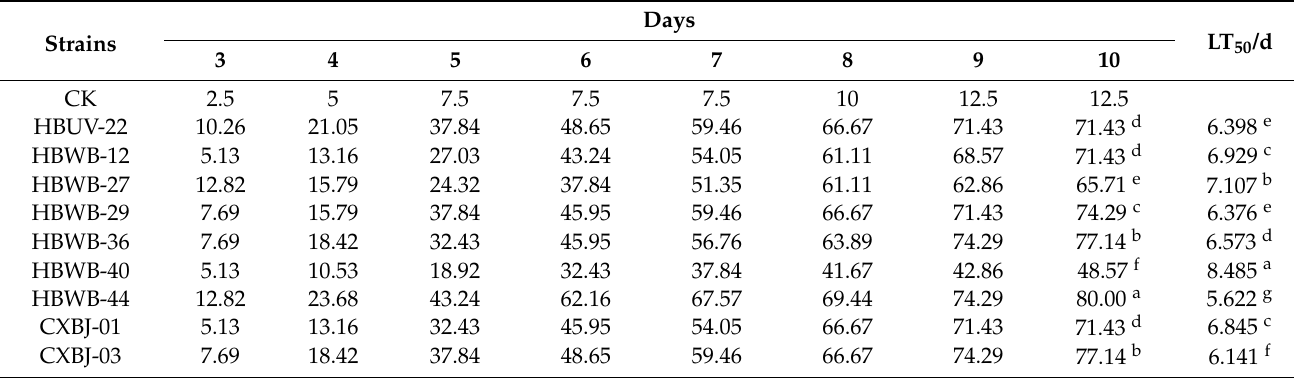
Table 4. Corrected mortalities (%) and LT 50 of P. bilinealis treated with positive microwave-mutant strains of B. bassiana .